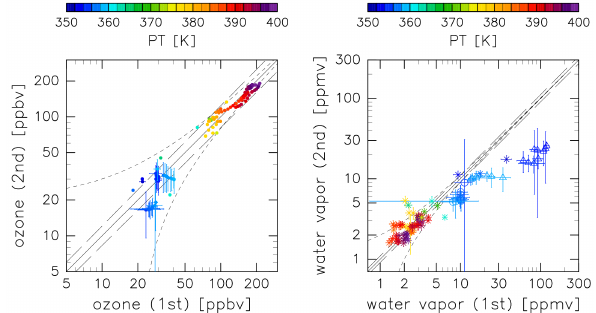
Fig. 4. As for Fig. 2 but for matches identified after applying all of the screening procedures (Sect. 3.3). In the right panel, the axes are modified compared with Fig. 2 and the symbols refer to the hy- grometers, i.e., crosses, triangles, and circles indicate paired obser- vations by CFH and CFH (for the first and second observations, respectively), CFH and SW, and SW and SW, respectively.